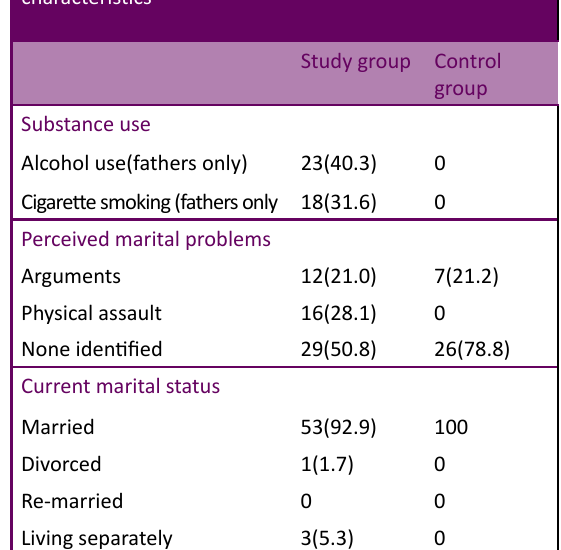
Table 2- Comparison of study group and control group characteristics